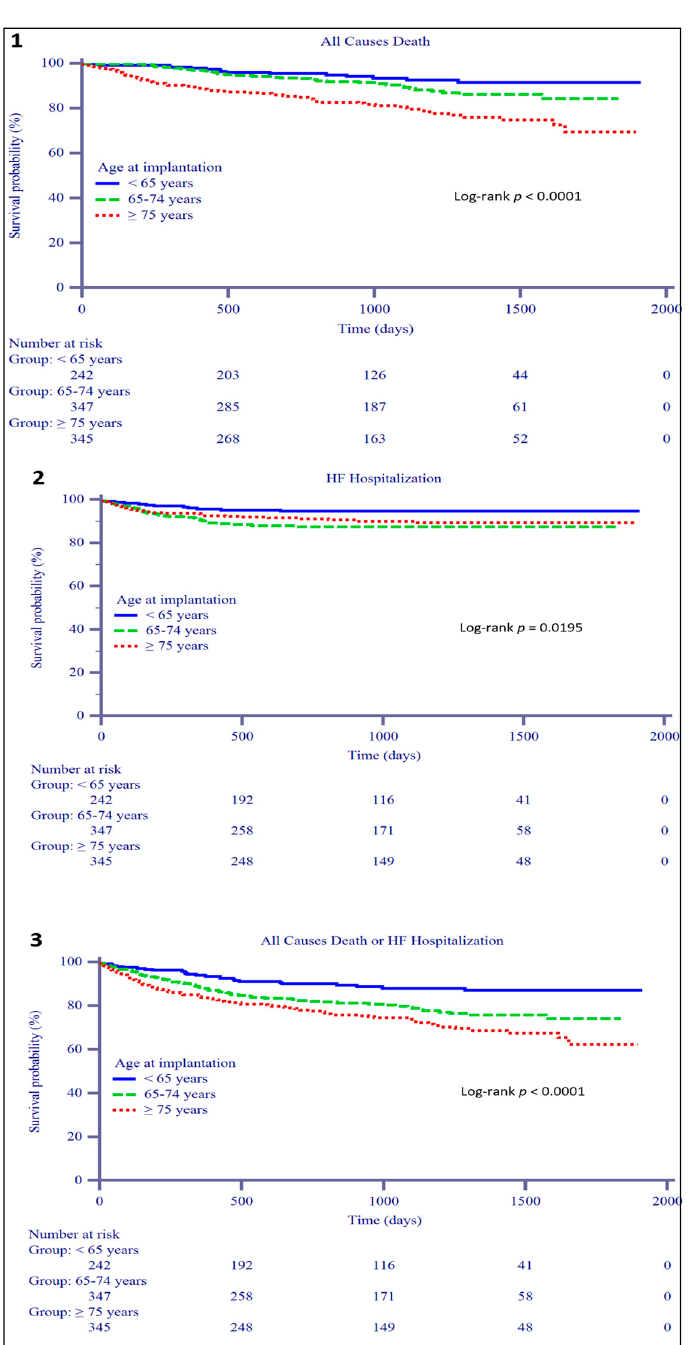
Figure 1. Long-term outcomes according to age group. The Kaplan – Meier curve for survival is